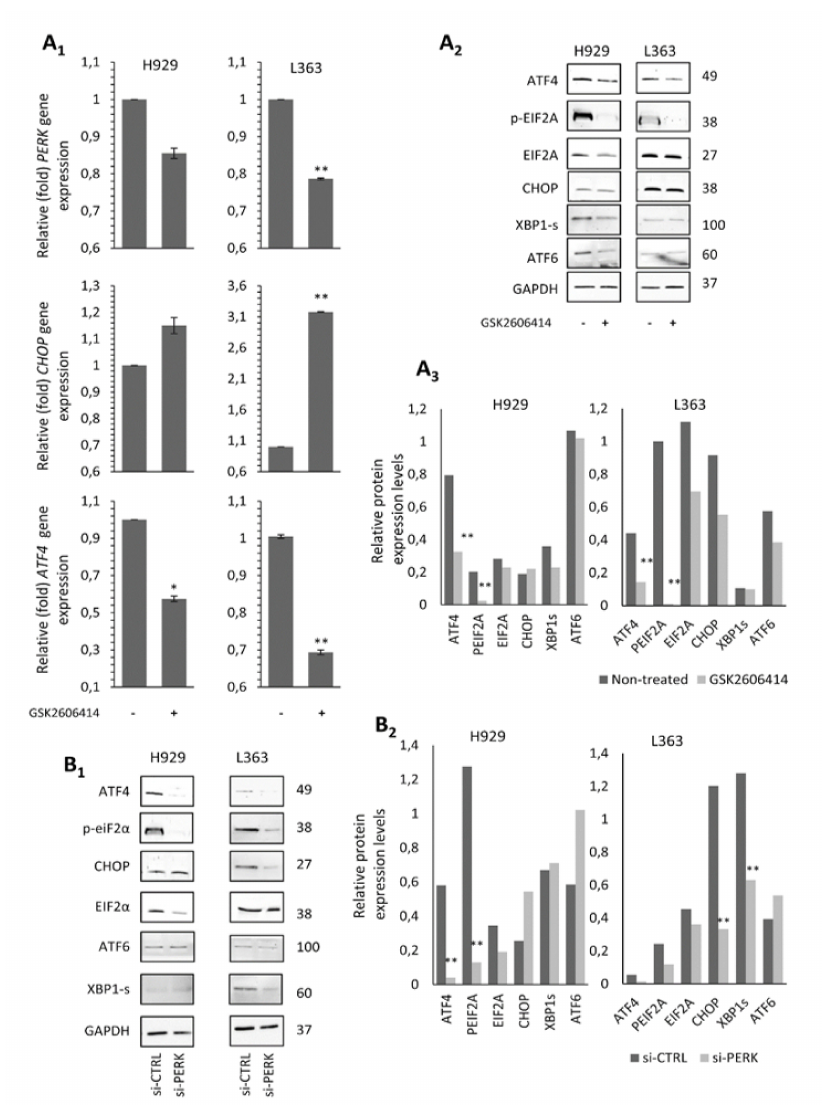
Figure 4. ( A 1 ) Q-PCR expression analyses of PERK , ATF4 and CHOP mRNA expression levels in the H929 and L363 MM cell lines before ( − ) and after ( + ) incubation with 10 µ M GSK2606414 for 48 h. ( A 2 ) Representative immunoblotting analyses of protein samples probed with antibodies against ATF4, p-eIF2A, eIF2A, CHOP, XBP1s and ATF6. ( A 3 ) Quantitation of expression levels of analyzed proteins. ( B 1 ) Immunoblotting analysis of protein samples probed with antibodies against ATF4, p-eIF2A, eIF2A, CHOP, ATF6 and XBP1s after transfecting H929 and L363 cell lines with PERK RNAi